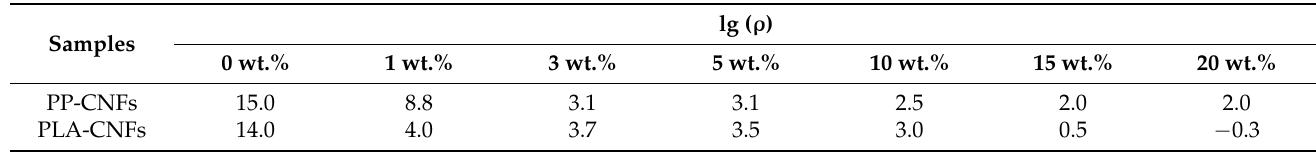
Table 2. R values corresponding to different concentrations of carbon nanofibers for PP-based and PLA-based composite